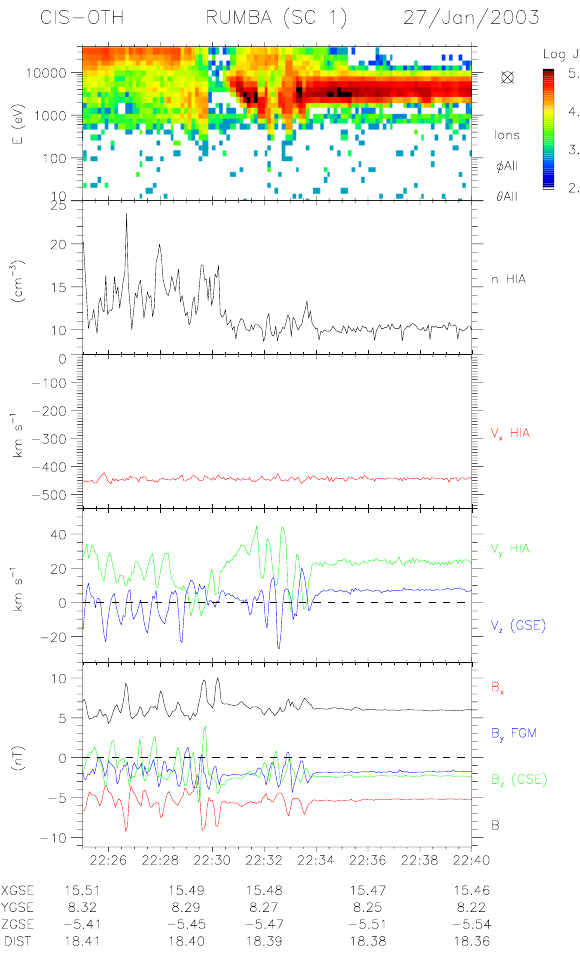
Fig. 4. Cluster-CIS and FGM observations for 6 April 2003. The format is the same as Fig.